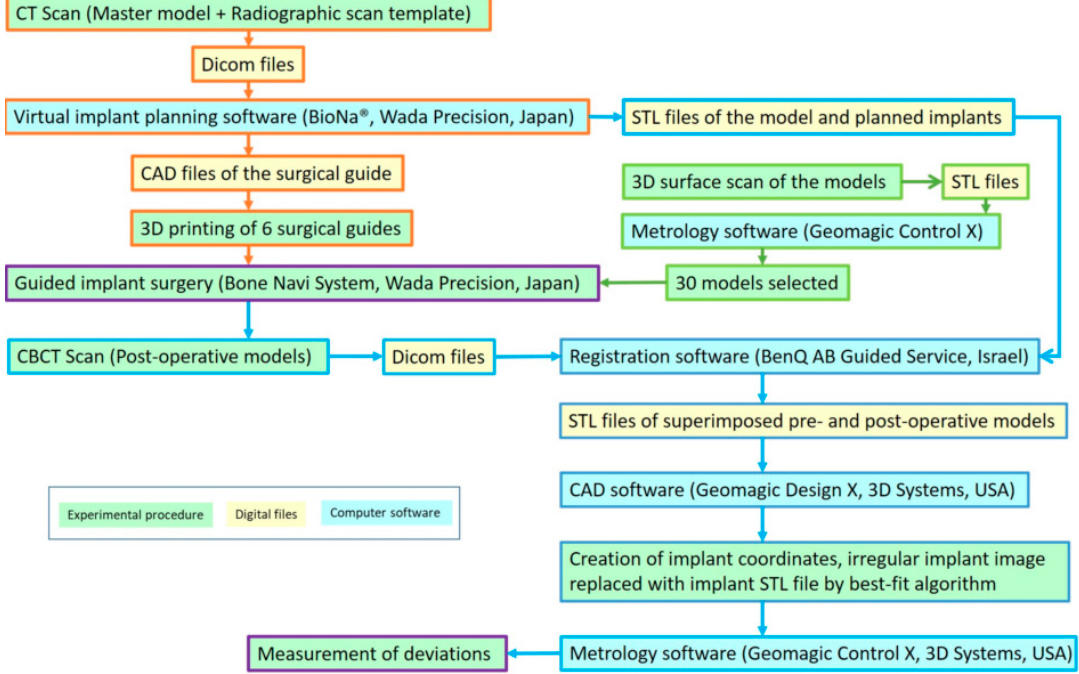
Figure 6. Summarized workflow of the experiment. Orange arrows: Procedure of surgical guide fabrication; green arrows: Procedure of model selection; and blue arrows: Procedure of deviation measurement.